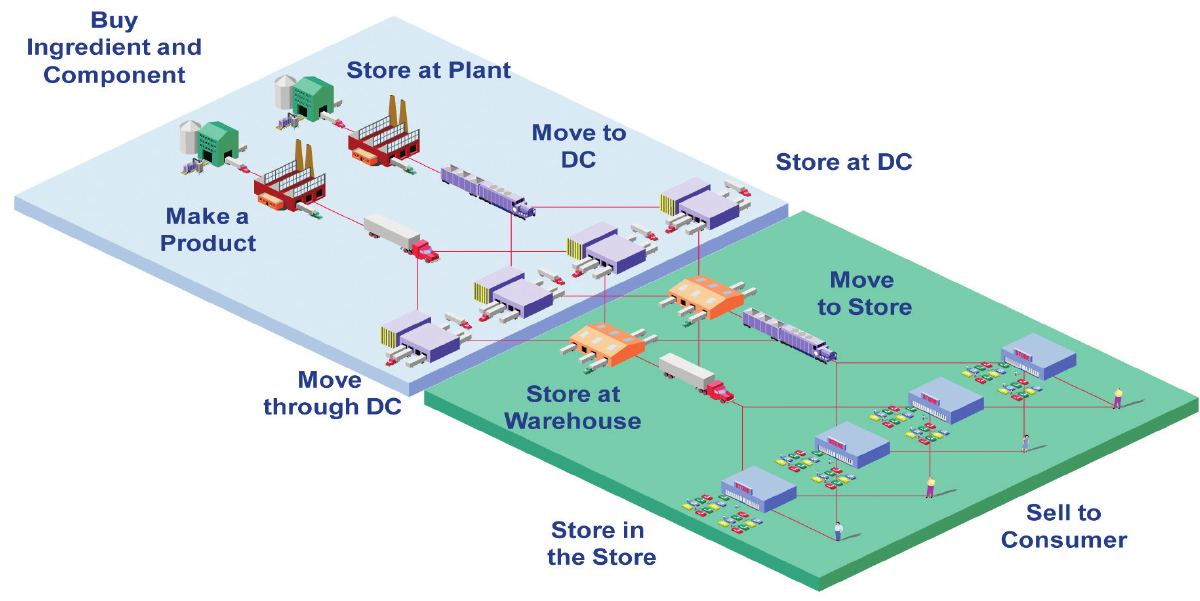
Figure 1: Supply chain activities in a consumer goods supply chain (Kumar,